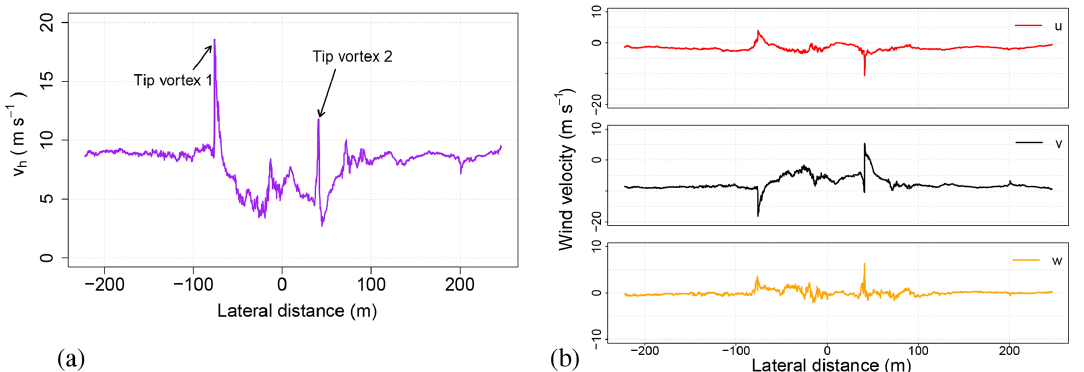
Figure 13. (a) Horizontal wind v h measurement at hub height in the WEC wake at a distance of 0.25D to the nacelle. The two tip vortices are indicated by the arrows. (b) The same measurement split into the three wind components ( u,v,w ). The x axis is relative easting with the WEC position as origin ( (cid:49)x in Fig. 7).